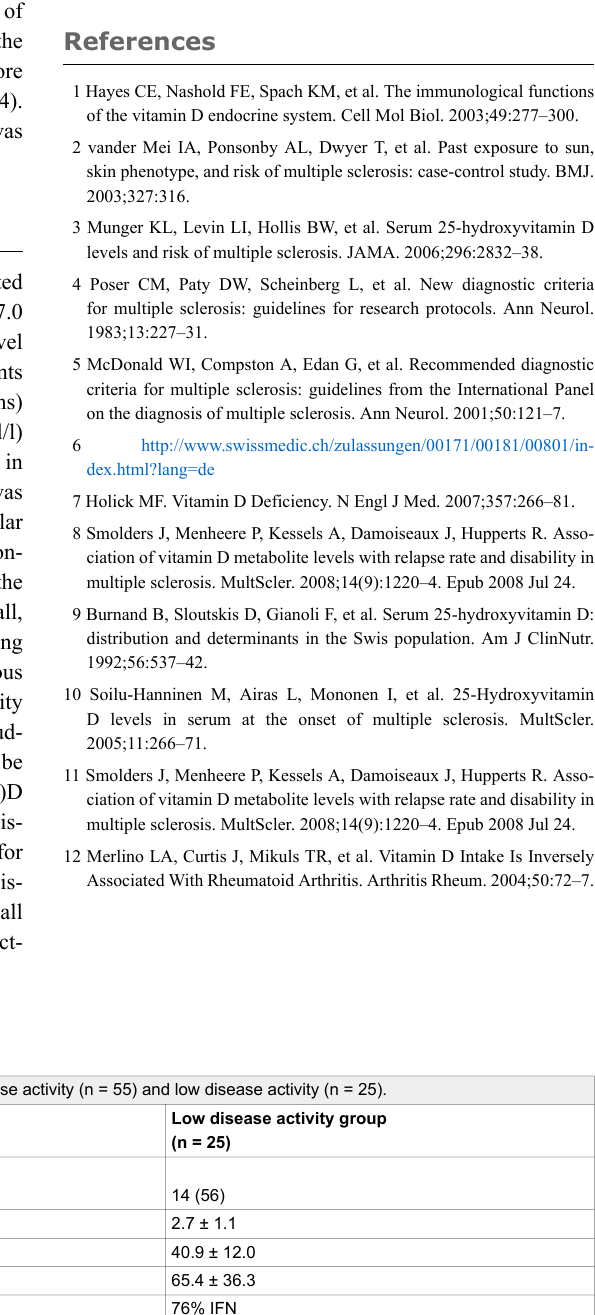
High disease activity group (n = 55)